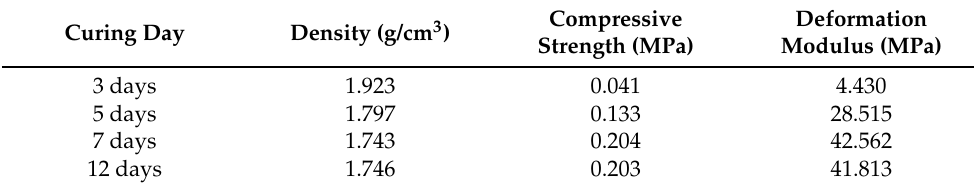
Figure 3. Actual photos of the raw materials. Table 2. Physical and mechanical indexes of similar materials from primary